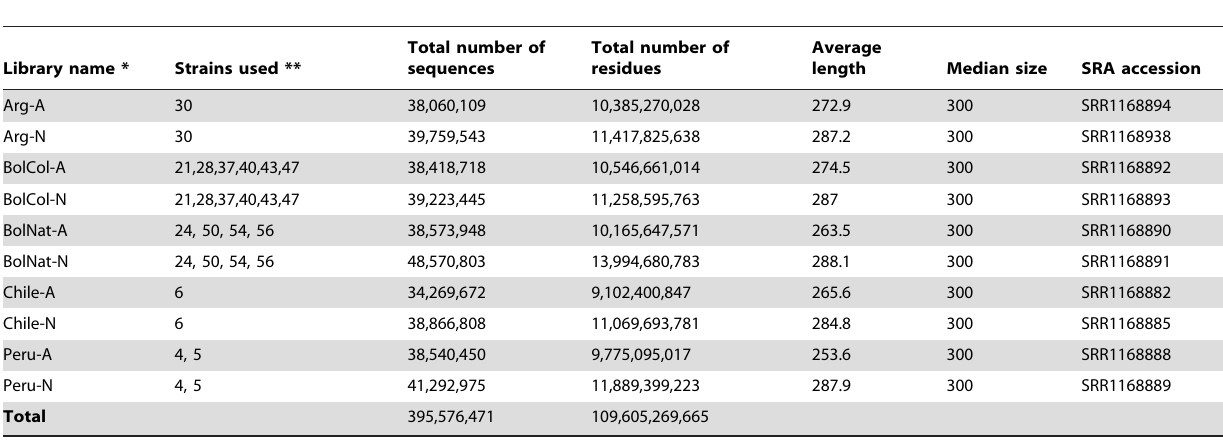
Table 1. RNAseq metadata from T. infestans sialotranscriptomes following trimming of low quality ( , 10) ends and rejection of average quality ,